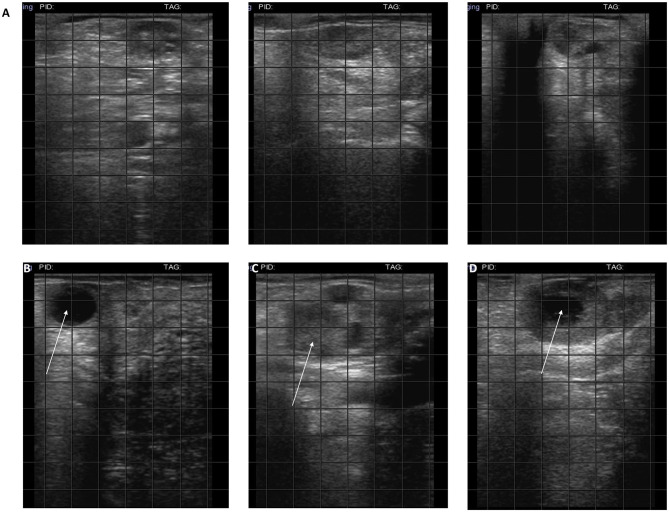
Ultrasound of ovaries. (A) Hypogonadal ovaries; (B) the arrow indicates 2 cm follicles; (C) the arrow indicates a corpus hemorrhagicum; (D) the arrow indicates a corpus luteum.